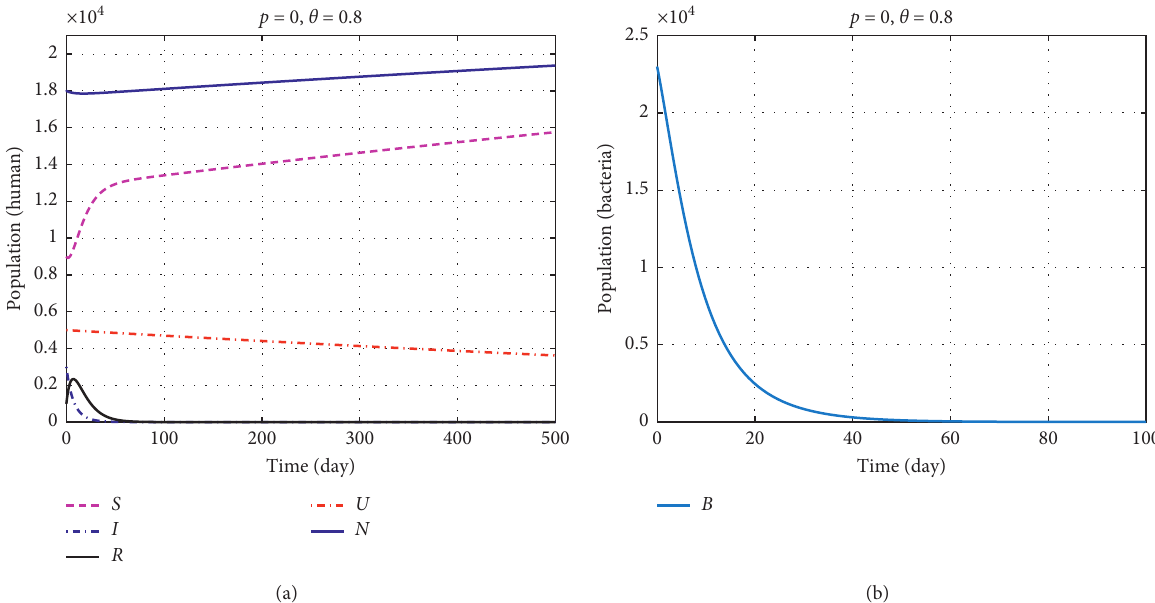
Figure 5: Time series solution of individual (a) and bacteria (b) cohorts when p � 0 and θ � 0 . 8. The diseases die out ( R